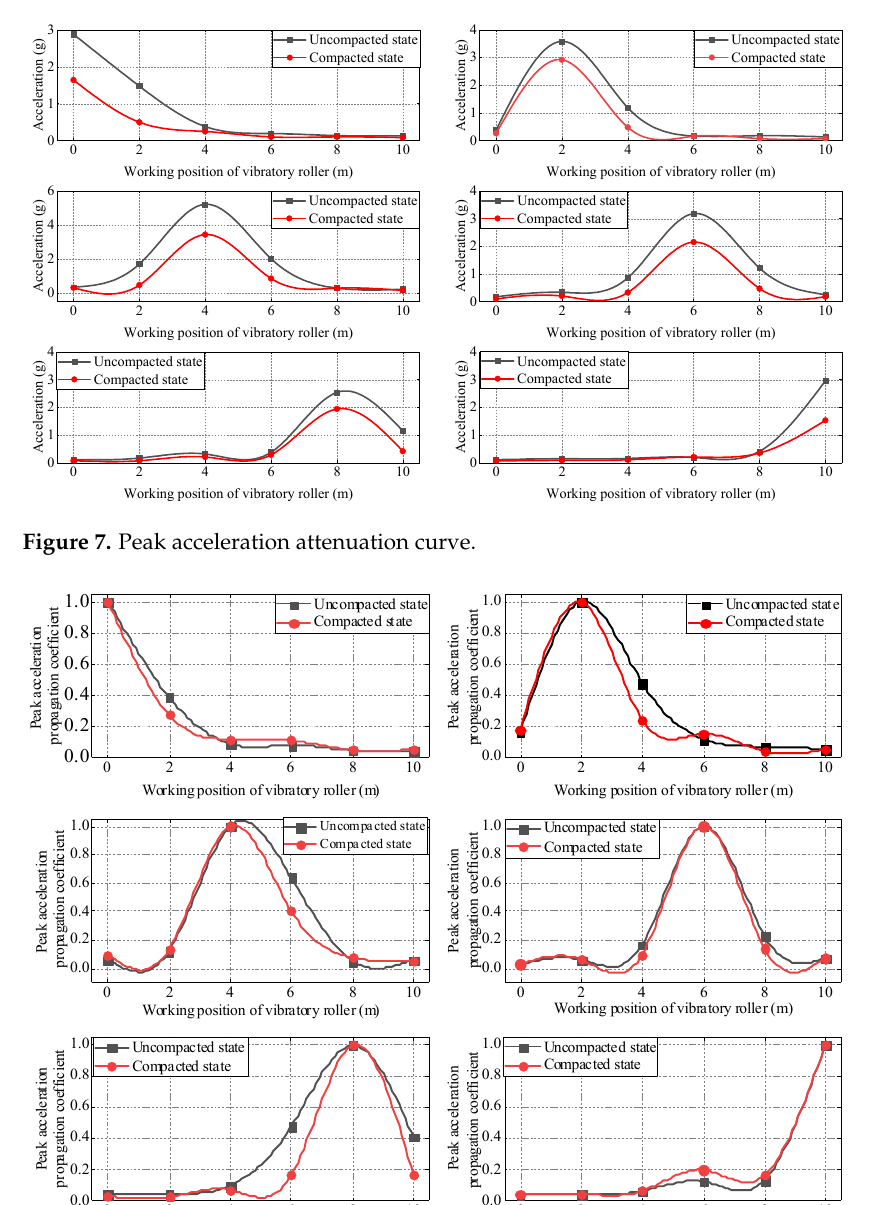
Different speeds of the vibratory roller have a certain influence on the propagation law of the vibration wave in the filling. In order to further study the horizontal propaga- tion law and horizontal propagation coefficient of the vibration wave, in this paper, the peak acceleration propagation coefficient is selected under the conditions of strong vibra- tion when the speed of the vibratory roller is 1.5 km/h, 3 km/h and 4.5 km/h, and the filling under different compaction states are as shown in Figure 9. Figure 9a shows that the soil is in an uncompacted state, and the peak acceleration propagation coefficient has a negative correlation with the speed of the vibratory roller, that is, when the speed of the vibratory roller is 1.5 km/h, the vibration wave propagation coefficient in the horizontal direction is the largest, followed by 1.5 km/h, and the propa- gation coefficient is the smallest at 4.5 km/h. The analysis shows that when the soil is in the uncompacted state, the slower the speed of the vibratory roller, the better the propa- gation of the vibration wave along the horizontal direction. That is, the same test area is vibrated and compacted under the same working conditions, and the energy carried by the vibration wave is the same when the vibration wave moves from the vibratory roller